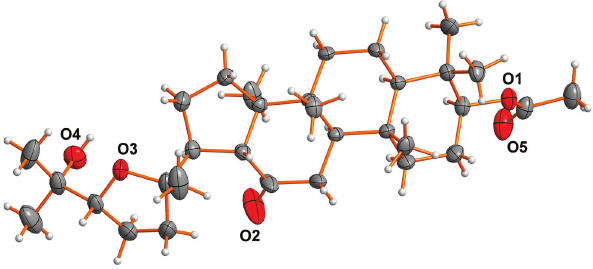
Table 1: Data collection and handling.